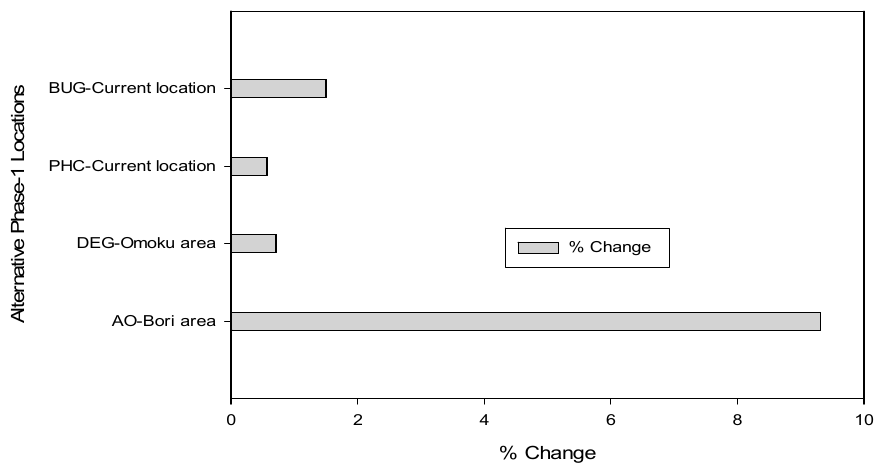
Figure 4. Basin peak flow response to GPH Phase 1 development in three alternative locations. It shows changes due to the Bori alternative location, which was considerably higher than changes in all other basins.